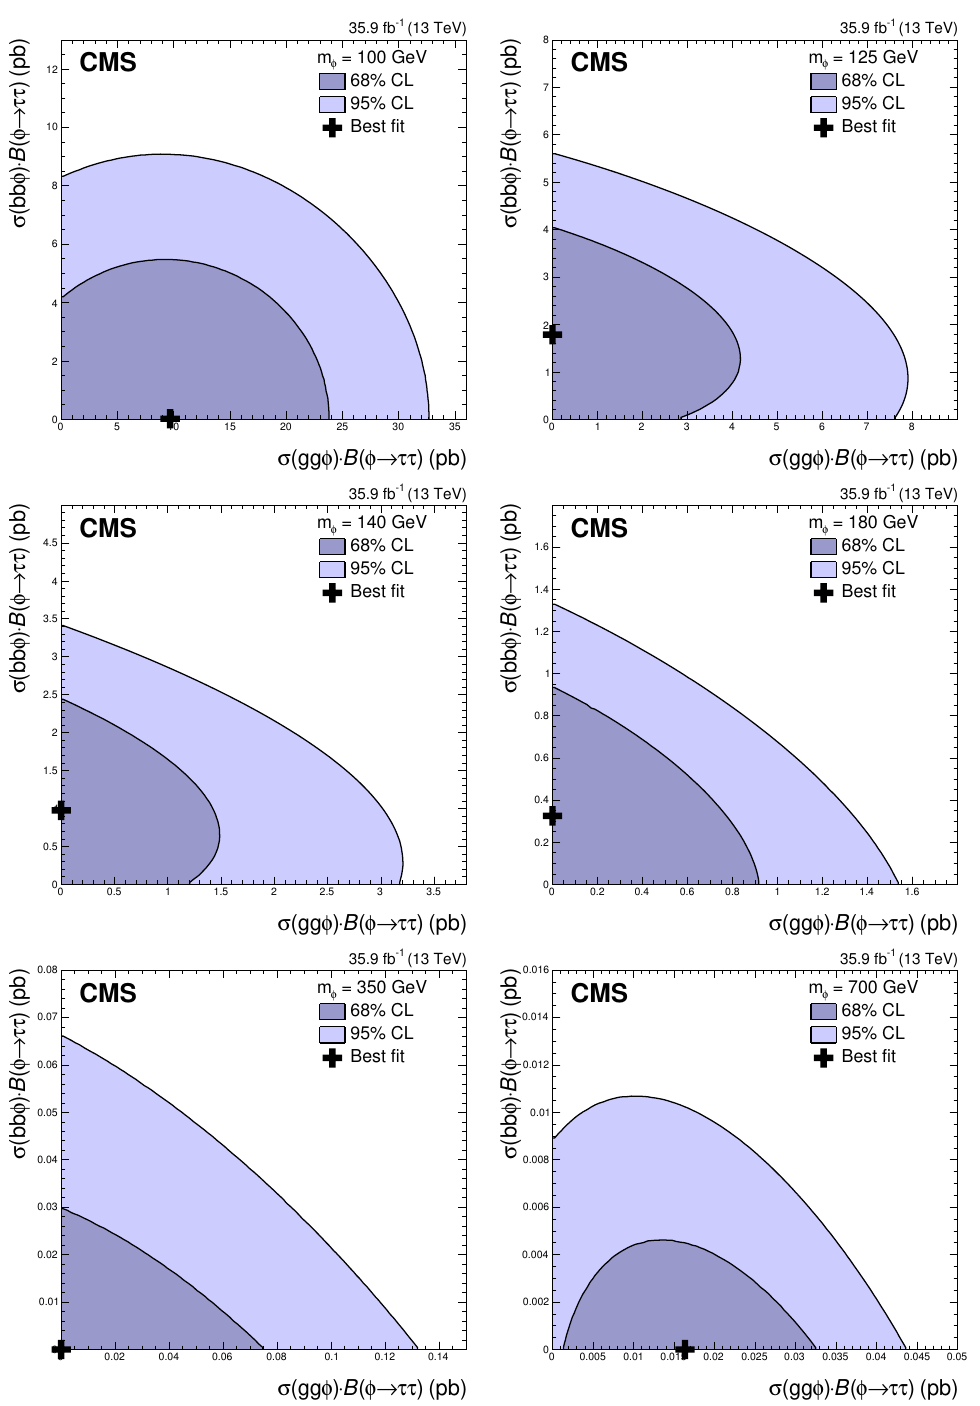
Figure 8 . Scan of the likelihood function for the search in the (cid:28)(cid:28) (cid:12)nal state for a single narrow resonance, (cid:30) , produced via gluon fusion (gg (cid:30) ) or in association with b quarks (bb (cid:30) ). A representa- tive subset of the mass points tested at (upper left) 100 GeV, (upper right) 125 GeV, (middle left) 140 GeV, (middle right) 180 GeV, (lower left) 350 GeV, and (lower right) 700 GeV is shown. Note that in the (cid:12)ts the signal strengths are not allowed to become negative.